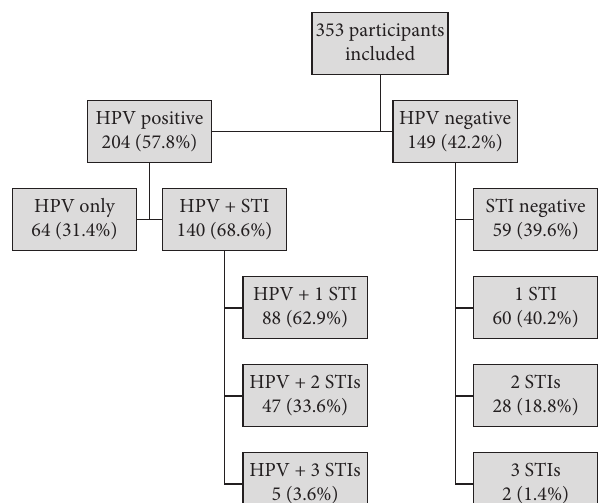
Figure 1: Fluxogram of 353 sexually active women included in the study. HPV: Human papillomavirus ; STI: sexually transmitted